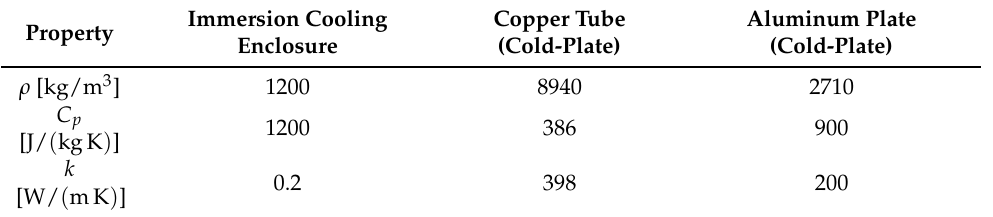
Table 3. Thermo-physical properties of solid regions used for immersion and cold-plate cooling